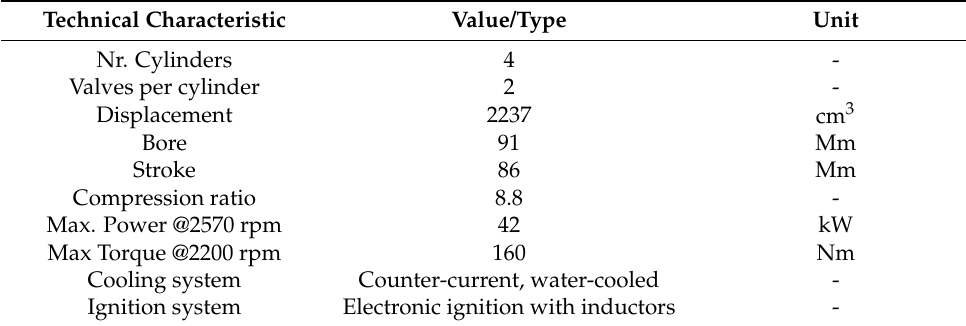
Table 1. Toyota 4Y-E technical data.